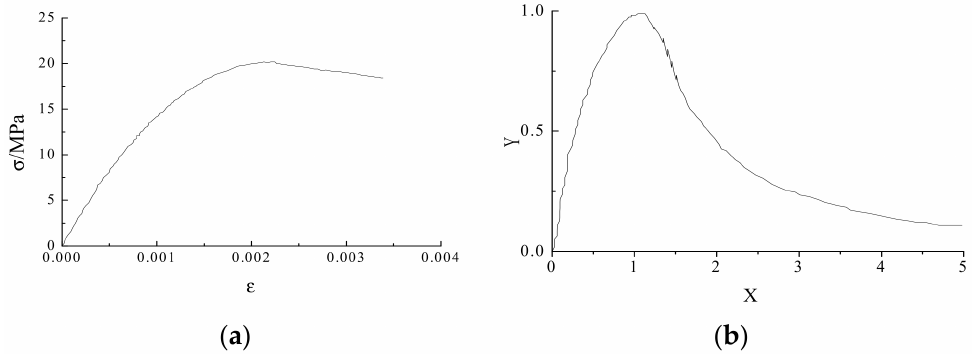
Figure 11. Constitutive curves of new-type blocks: ( a ) compression constitutive curve ( b ) tensile constitutive